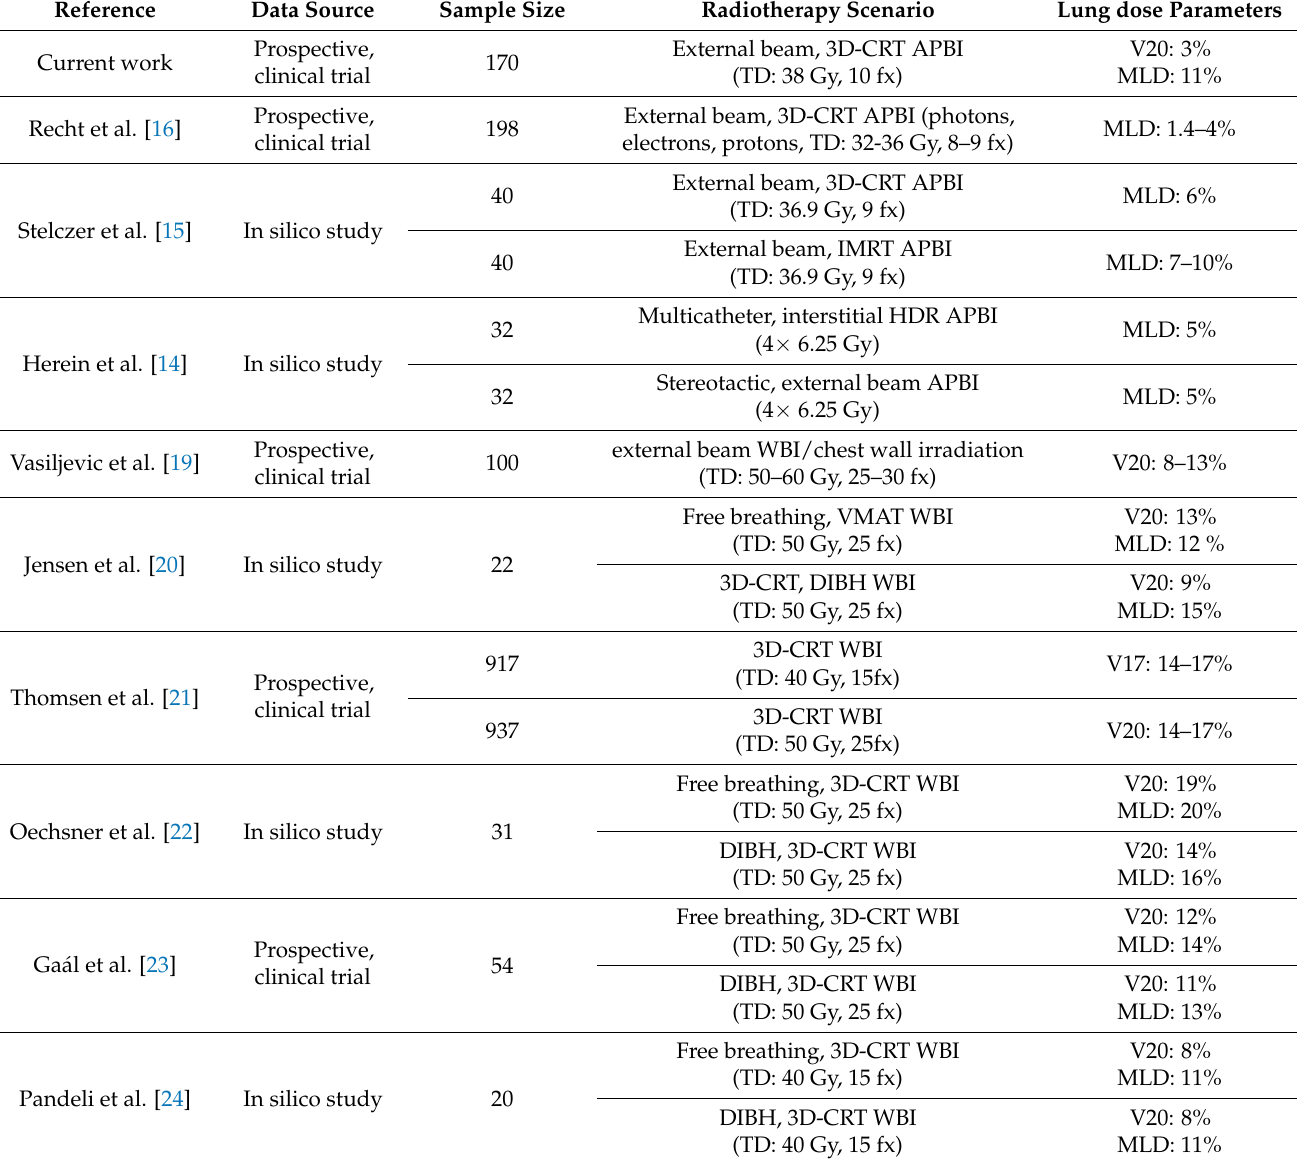
Table 2. Typical ipsilateral lung doses of radiotherapy of breast cancer related to different treatment